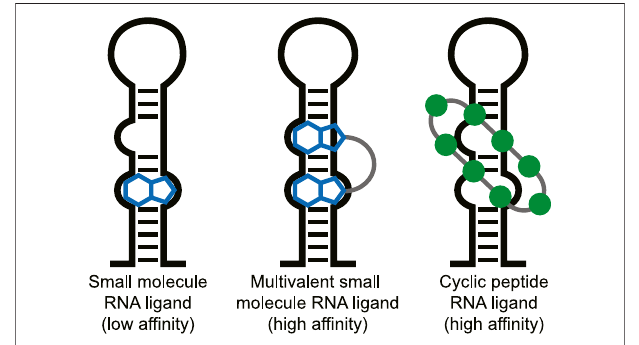
FIGURE 1 | Different types of ligands can be used to target individual or multiple RNA secondary structures.